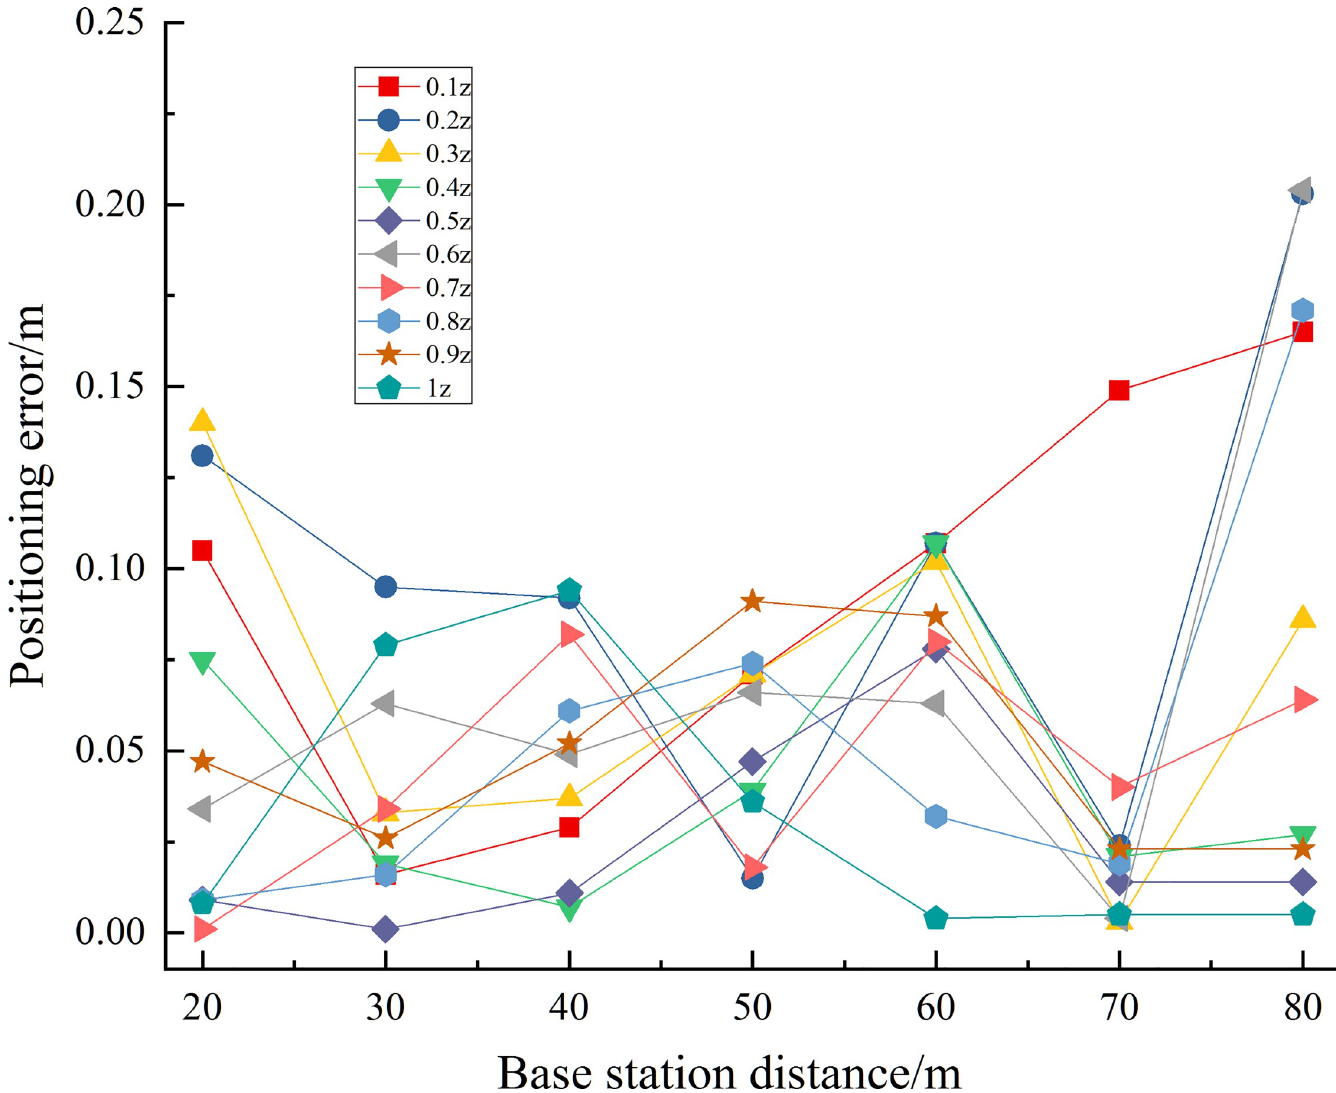
Fig 16. Errors in different test distances for separations of positioning base stations ranging 20~80